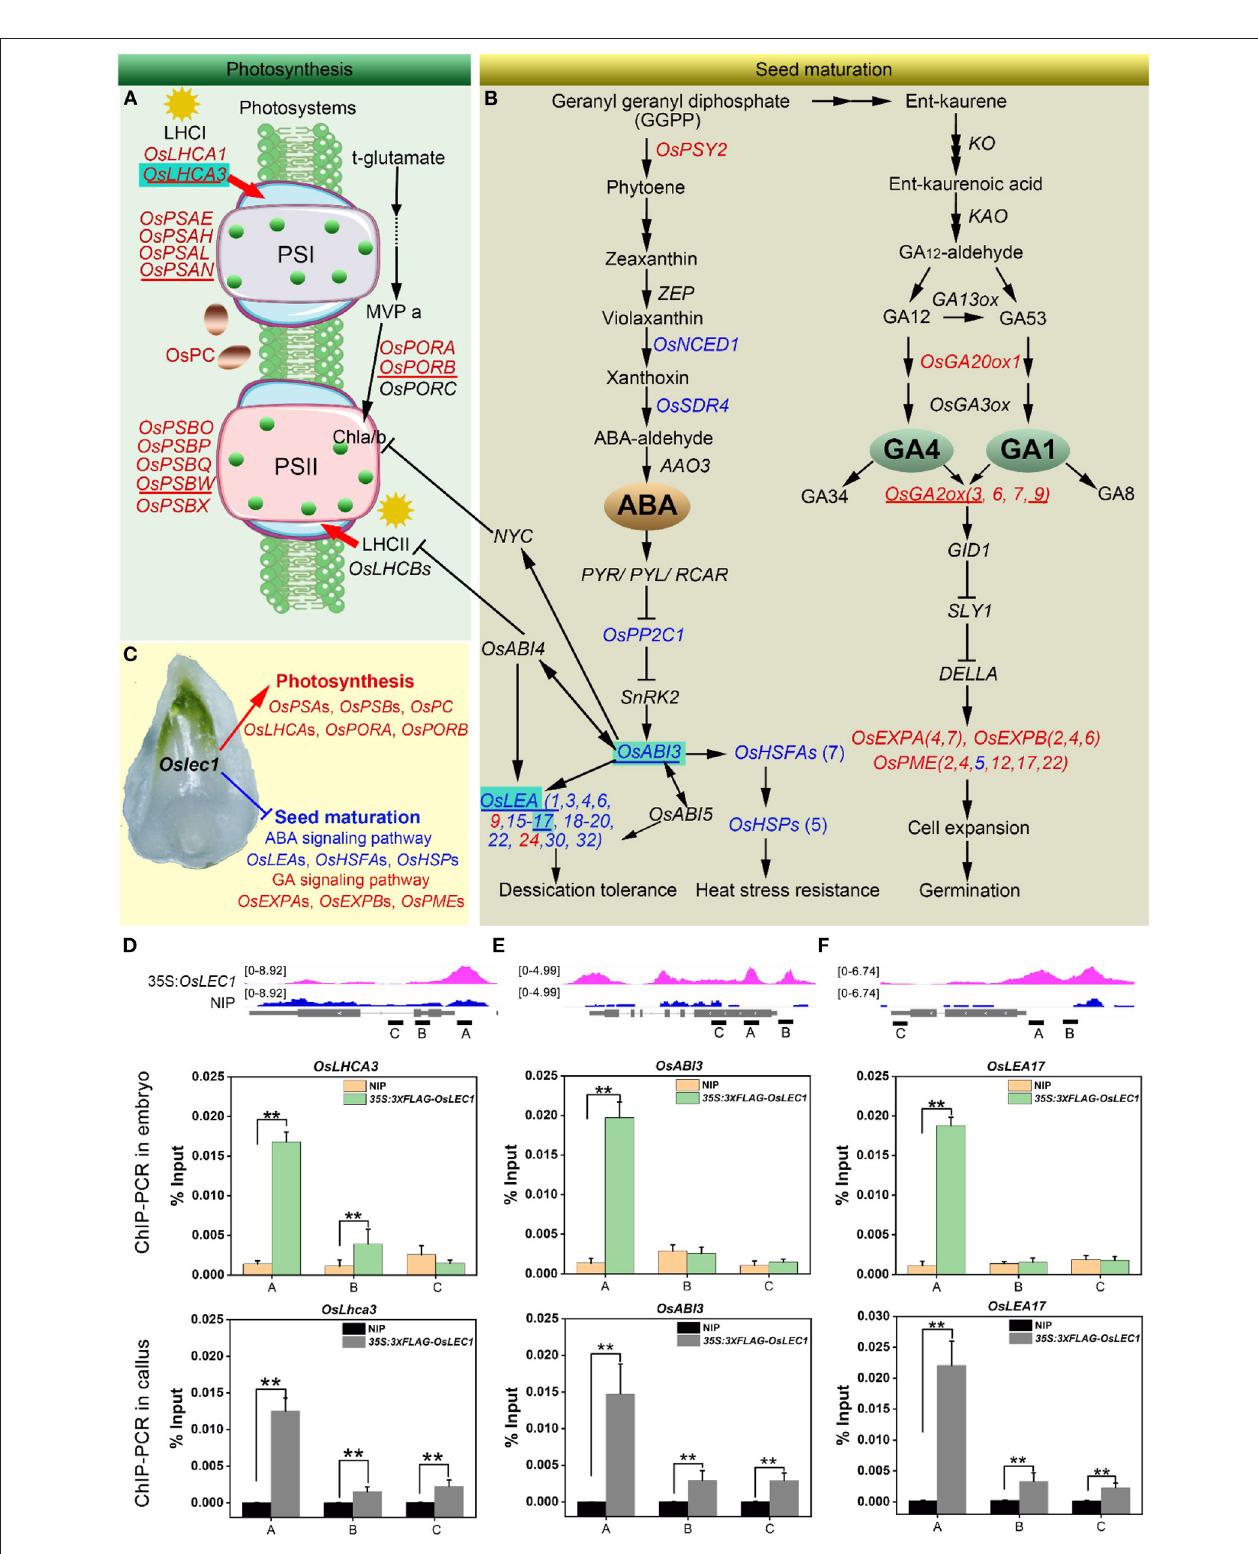
FIGURE 7 | A proposed model of the mutated Oslec1 action. (A) Photosynthesis-related genes were up-regulated in the Oslec1 mutant, including genes encoding key enzymes PSI, PSII, LHCI, LHCII and OsPC, etc. (B) Oslec1 mutation regulated genes involved in seed maturation, including genes in ABA/GA biosynthesis and signaling pathways. (C) Oslec1 mutation results in the activation of photosynthesis and the inhibition of seed maturation. Genes underlined indicate that they are verified by qRT-PCR. Genes in red indicate that they are upregulated in Oslec1 embryos, and directly bound by OsLEC1; genes in blue indicate that they